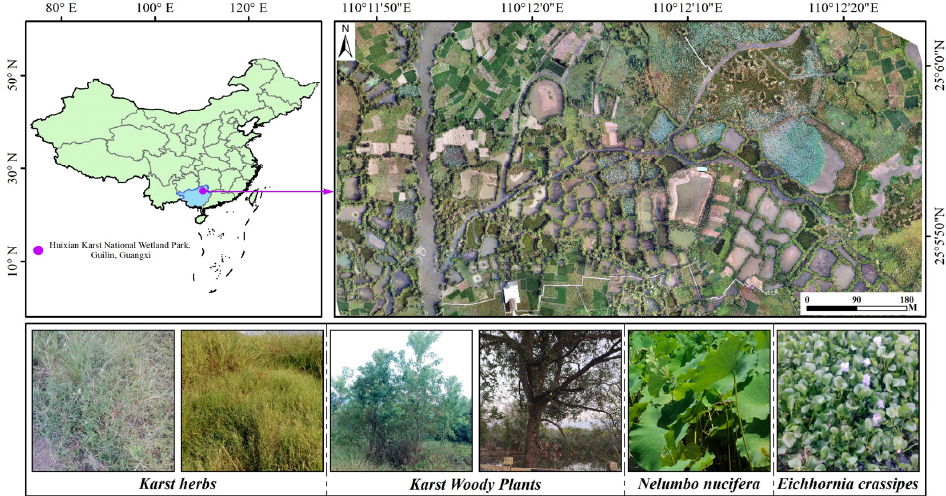
Figure 1. Geographical location of study area and field measurements.